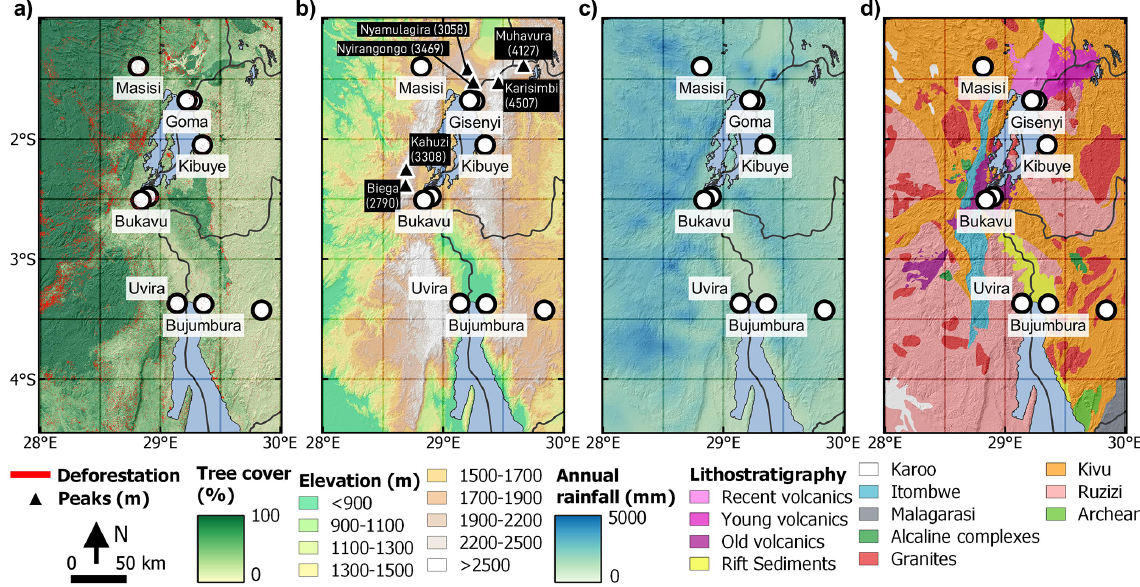
Figure 2. Environmental characterization of the NTK rift: (a) tree cover for the year 2000 and deforestation from 2001–2017 (Hansen et al., 2013), (b) elevation and some renowned mountain peaks (height expressed in meters) (USGS, 2006), (c) average annual rainfall